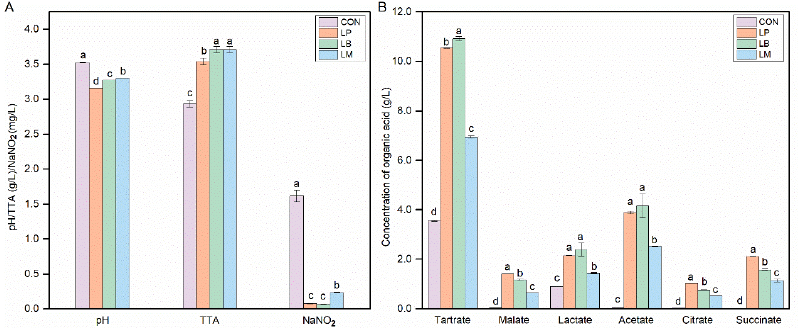
Figure 1. The contents of physicochemical properties ( A ) and organic acids ( B ) in Suancai fermented with different autochthonous LABs. CON, natural fermented Suancai. LP, LB, and LM represent the inoculated Suancai with Lb. plantarum , Lb. brevis , and Leu. mesenteroides . TTA, total titratable acidity, expressed in % lactic acid. Different letters represent significant differences ( p < 0.05). 3.2. The Diversity of Microbial Community in Suancai with Different Starters Based on the sequencing, 83,933 16S rRNA gene clean tags were obtained from 12 Suancai samples. By means of assembling and filtering, about 81,958 valid tags remained for the next study. The valid tags of all samples ranged from 1480.27 to 1487.86 bp. The coverage of samples was more than 0.99 (Table 1), which showed that the main bacterial phylotypes of samples had been covered. After removing the chimera processes, the bac- teria numbers of observed species were 16.00 – 28.57 (Table 1). The assessment of the spe- cies number was evaluated by the Chao1 indices. The Chao1 values of LP, LB, and LM were higher than that of CON (Table 1). The Shannon and Simpson indices as diversity estimators, represented the approximated number of OTUs and the evenness of their dis- tribution in the samples. The samples fermented with different starters had significantly higher values of Shannon and Simpson indices than the CON (Table 1). After fermenta- tion, the LM had the highest Simpson and Shannon index of bacterial communities. Table 1. Alpha index of Suancai fermented with different autochthonous LABs. Samples 1 CON